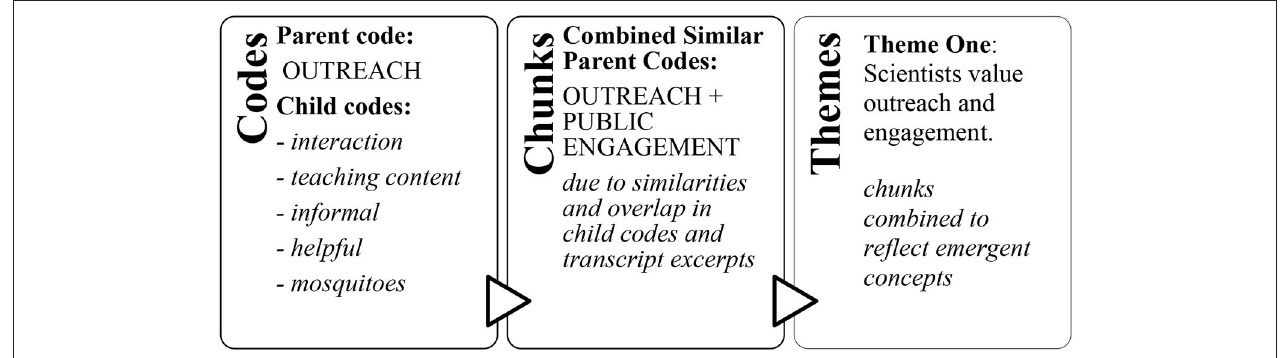
FIGURE 2 | The researchers’ qualitative coding process for arriving at thematic results.